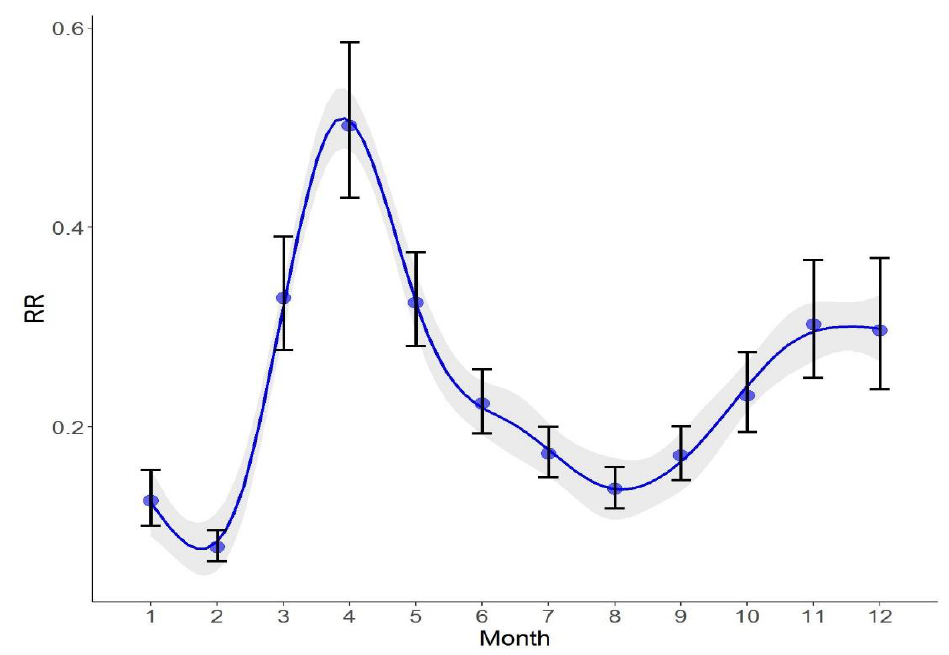
Figure 2. Temporal risk trend of HFMD incidence during 12 months in the year